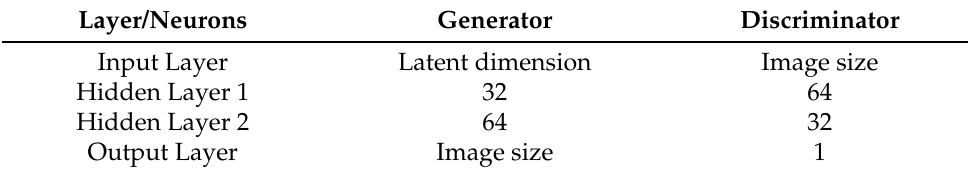
Table 2. Multilayer perceptron architecture of both Generator and Discriminator.